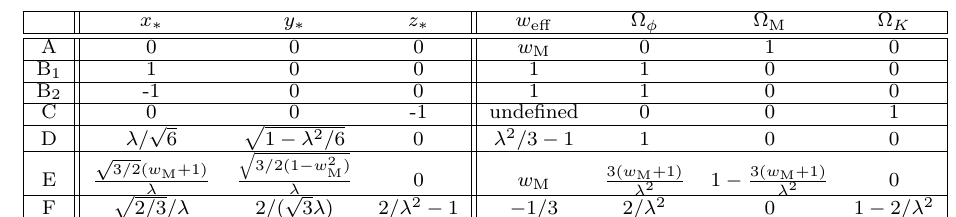
TABLE 2 List of fixed points and theirr properties for the three dimensional